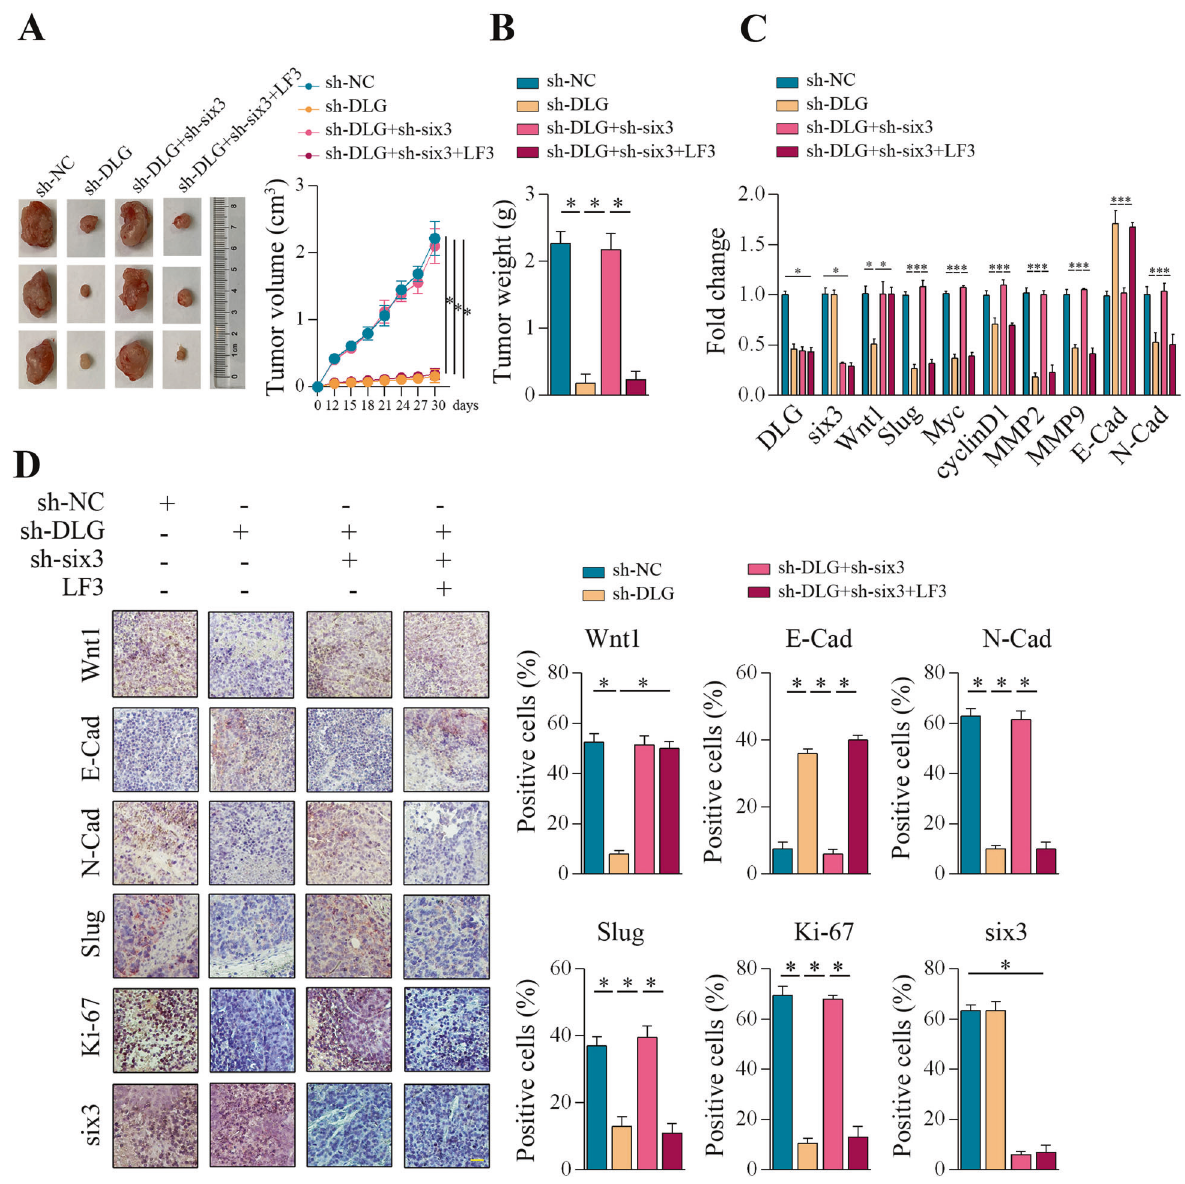
Fig. 7 DLGAP1-AS2 regulated GC progression via Six3/Wnt1/ β -catenin signaling pathway in vivo. A Tumor samples and growth curves from sh-NC, sh-DLGAP1-AS2, sh-DLGAP1-AS2 + sh-Six3, and sh-DLGAP1-AS2 + sh-Six3 + LF3 groups were shown ( n = 6 for each group). B Tumor weight from the respective groups was represented. C RT-qPCR analysis of DLGAP1-AS2, Six3, Wnt1, Slug, Myc, cyclinD1, MMP2, MMP9, E-cadherin, and N-cadherin in xenograft tumors for each group. D IHC assays of Wnt1, E-cadherin, N-cadherin, Slug, Ki-67, and Six3 in paraf fi n tumor sections for each group. Scale bar: 50 μ m. * P <